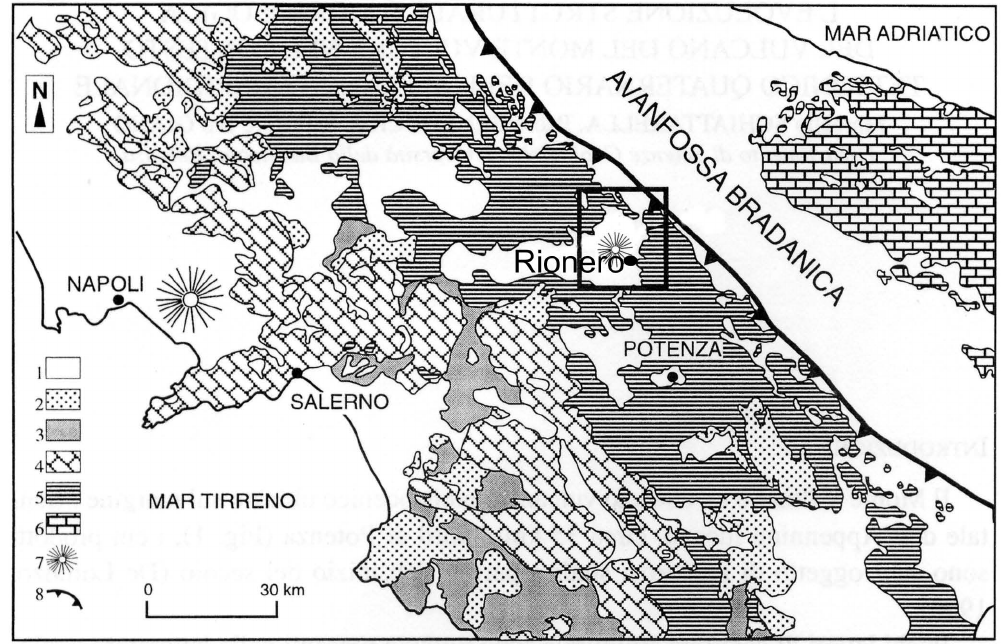
Fig. 1. Tectonic outline of the southern Apennines. 1=Bradanic foredeep and intrapenninic sediments. Volcanoclastic rocks (plio-quaternary); 2=Sinorogenic sediments (Miocene); 3=Liguride complex (Cretaceous-Oligocene); 4=Apennine plataform carbonate (Mesozoic-Cenozoic); 5= Lagonegro basin sediments (Trias-Miocene); 6=Apulian plataform sediments (Trias-Pliocene); 7=Volcanoes; 8=Buried allochthonous front. Vulture area is shown from the rectangle (from Pescatore et al., 1999,